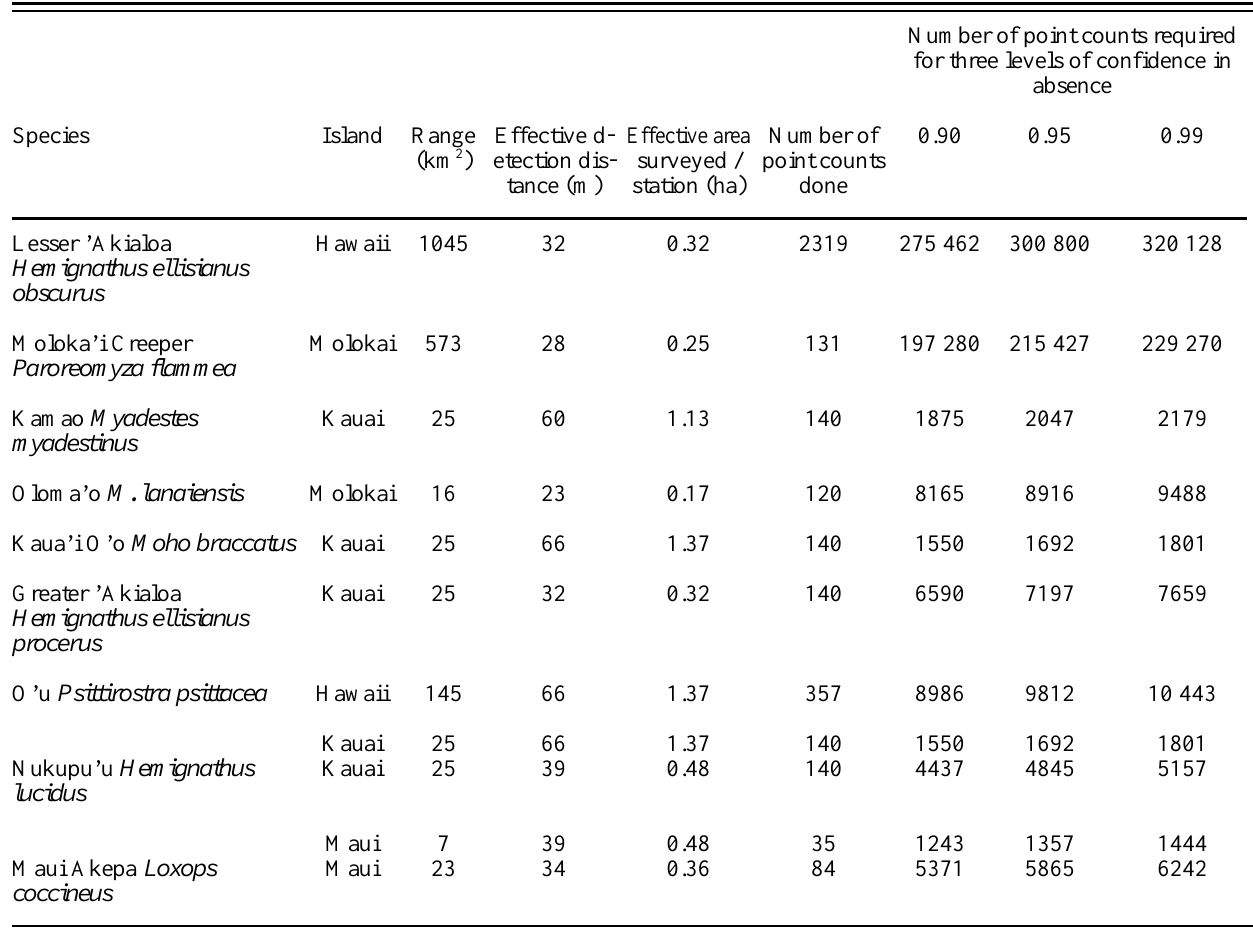
Table 1. Search effort required to make statement of probability of absence (extinction) for eight species of Hawaiian forest birds. All have been suggested for delisting by the U.S. Fish and Wildlife Service and were reported as presumed extinct in a 2003–2004 report to Congress (U.S. Fish and Wildlife Service 2006b). Number of point counts required for three levels of confidence in absence Species Island Range Effective d Effective area (km 2 ) etection dis surveyed tance (m)